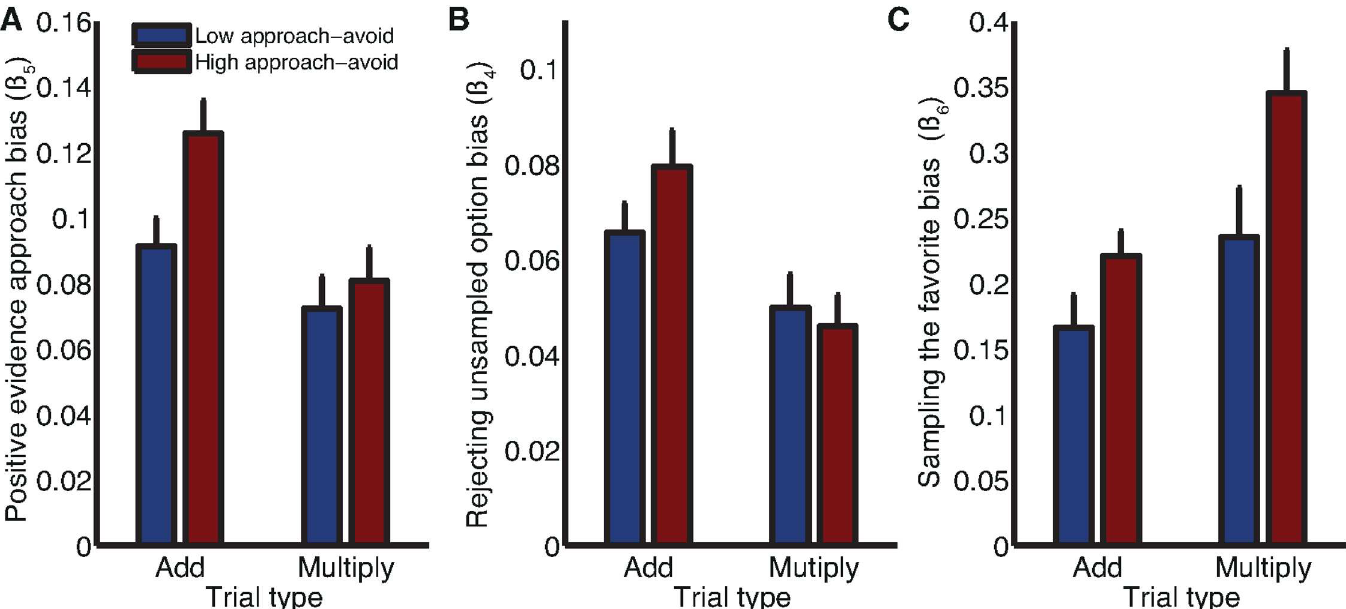
Fig 6. Expression of all three biases is differentially present in subjects with high versus low Pavlovian approach, quantified in a separate gambling task. Blue bars denote subjects with below-median values for β gain – β loss ; red bars denote subjects with above-median values. (A) The positive evidenceapproach bias is quantifiedusing the β 5 parameter in the parametric model of subject behavior; in both conditions, subjects with high approach- avoid parameter differences show more positive evidenceapproach than subjects with low parameter differences. (B) The rejecting unsampled option is quantifiedusing the β 4 parameter in the parametric model of subject behavior; in the add conditions, there is considerably greater expression of rejecting unsampledoption in subjects with high approach-avoid parameter differences; there is a weaker trend in the opposite direction in the multiply condition. (C) The samplingthe favorite bias is by quantifiedusing the β 6 parameter in the parametric model of subject behavior; in both conditions, subjects with high approach-avoid parameter differences show more samplingthe favorite bias than subjects with low parameter differences. Bars/error bars reflect mean/ standard deviationacross 1,000 bootstrapped samples of 10,000 gameplays. Data for reproducing all analysesis freely availablefor downloadfrom Dryad.